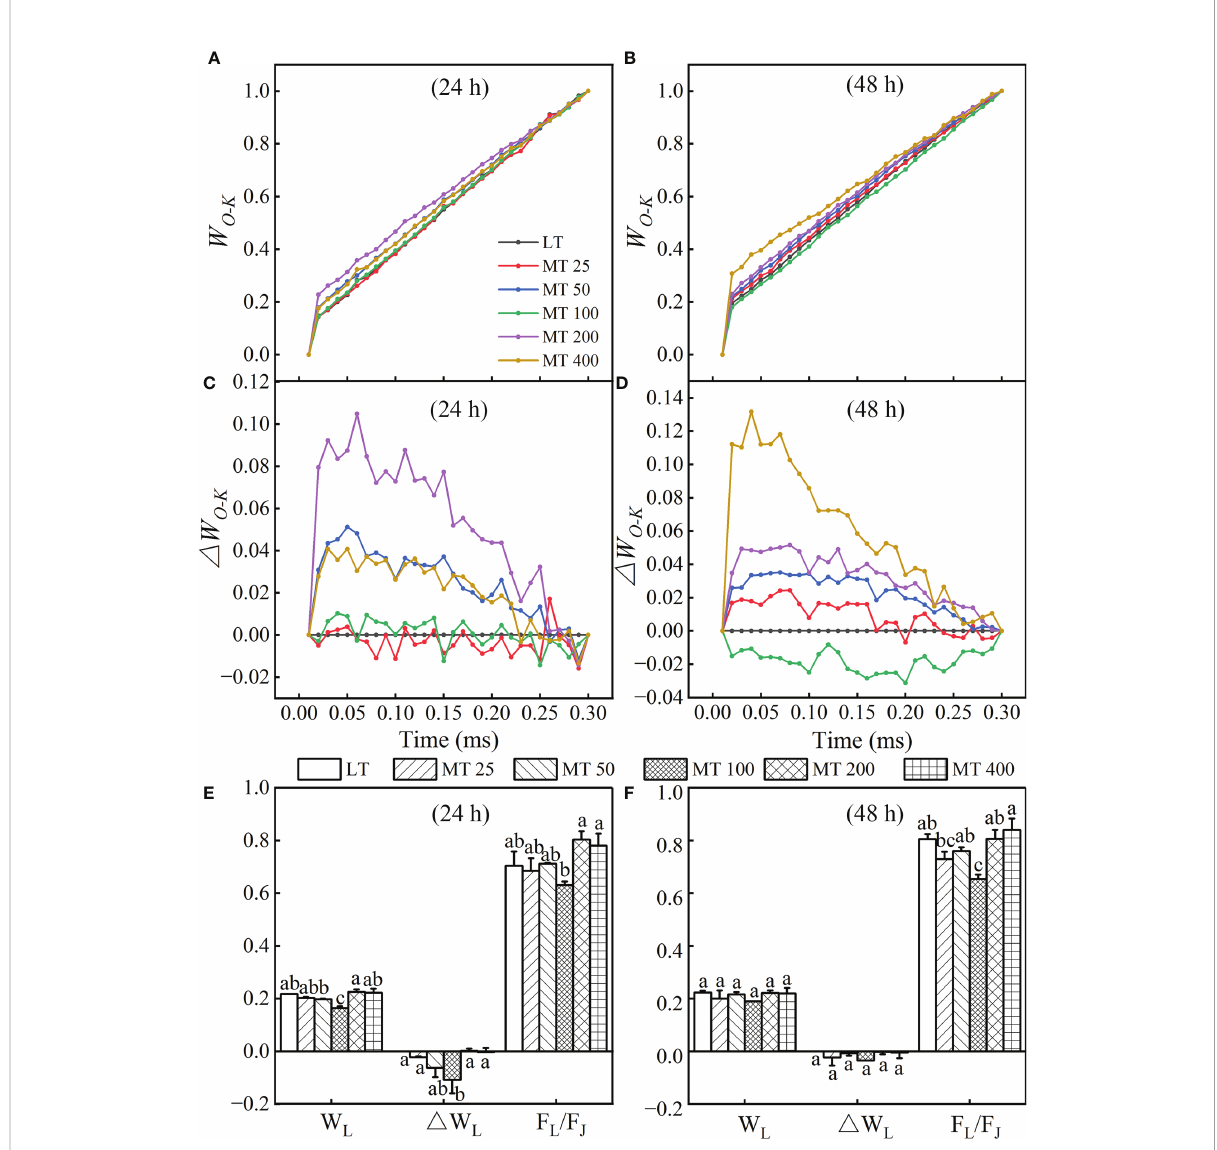
FIGURE 3 Effect of different melatonin (MT) concentrations on the L-band of low temperature-stressed cucumber plants. The OJIP kinetics normalized by O and K points, and calculated as: W O-K = ( F t – F O )/( F K – F O ).The difference kinetics D W O-K was calculated as D W O-K = W O-K (treatment) – W O-K (control) . (A, C) and (B, D) represent low temperature stress for 24 h and 48 h, respectively. The W L , cucumber plants at the low temperature stress for 24 h (E) and 48 h (F) . The values were represented by the means ± SE. The same letters denoted that there are no signi fi cant differences at P < 0.05 according to Duncan ’ s